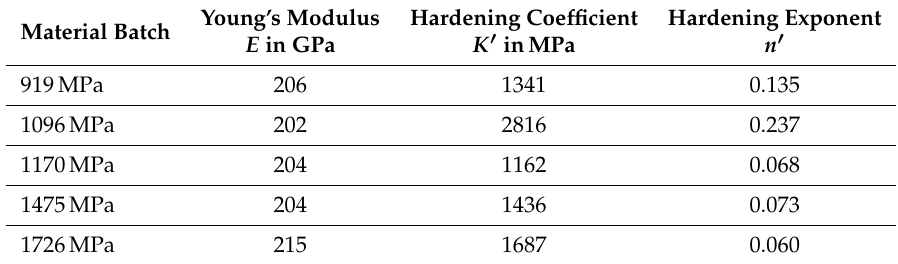
Table 3. Cyclic material